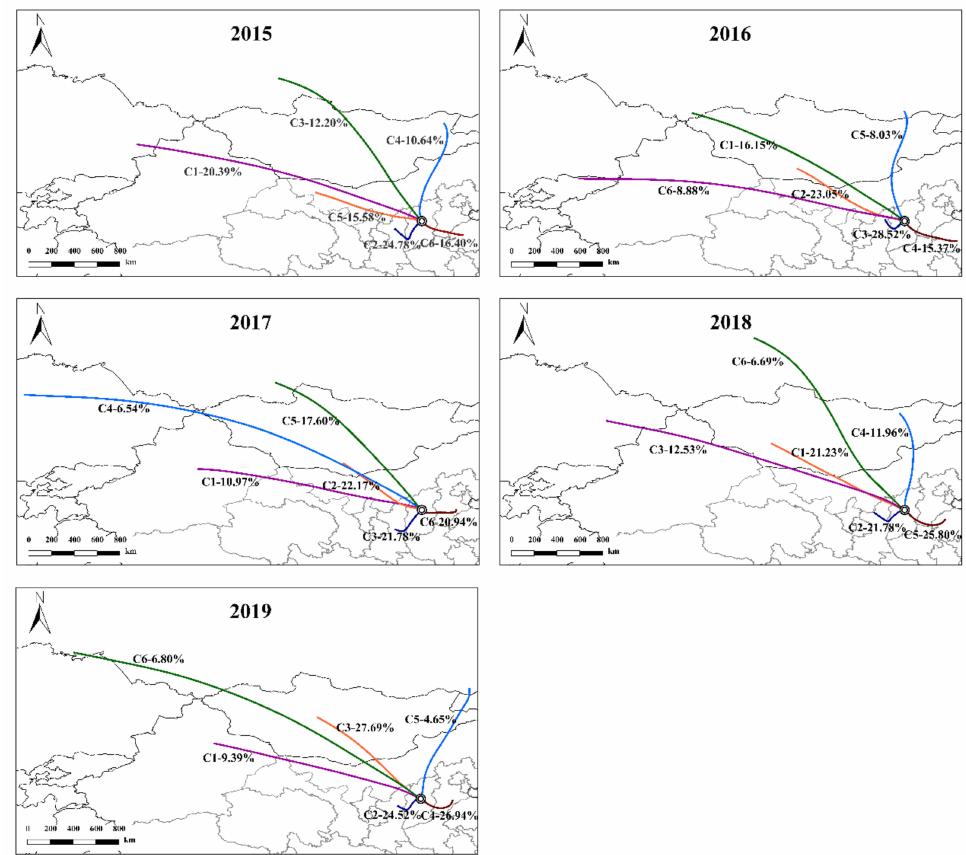
Figure 6. Backward trajectory clustering of Taiyuan city from 2015 to